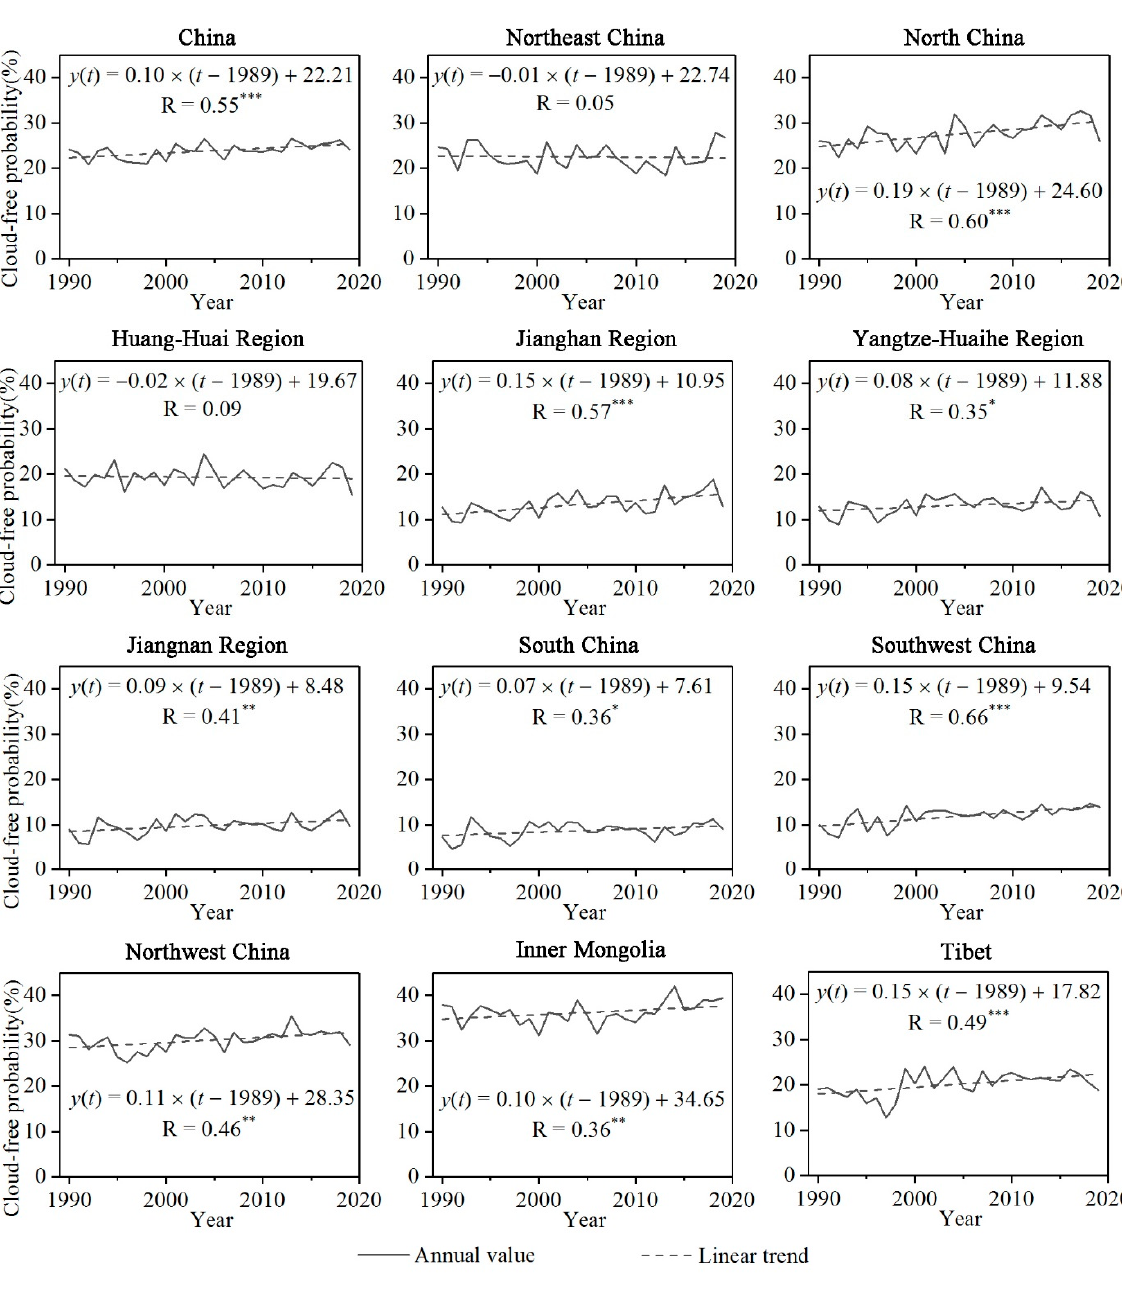
Figure 5. Annual time series for the probability of acquiring cloud-free imagery throughout the country and regions from 1990 to 2019. *** means that R is significant when the significance level α is set to 0.01; ** means that R is significant when the significance level α is set to 0.05; * means that R is significant when the significance level α is set to 0.1.